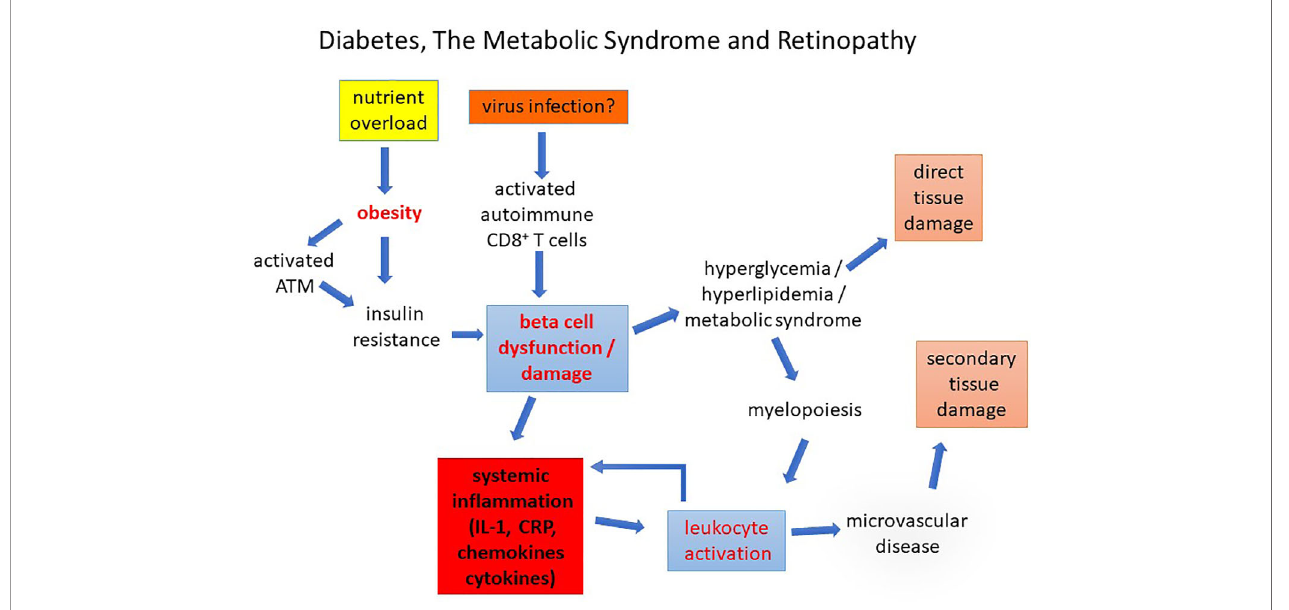
FIGURE 9 | Diabetes, The Metabolic Syndrome and Retinopathy. Diabetes caused by nutrient overload or autoimmune disease leads to beta cell dysfunction/loss inducing a chronic pro-in fl ammatory state in which leukocyte activation promotes early microvascular disease. This causes secondary tissue damage (retinopathy, nephropathy, and peripheral neuropathy). Direct damage to the tissues by chronic glycolipid toxicity develops more slowly compounding the pathological